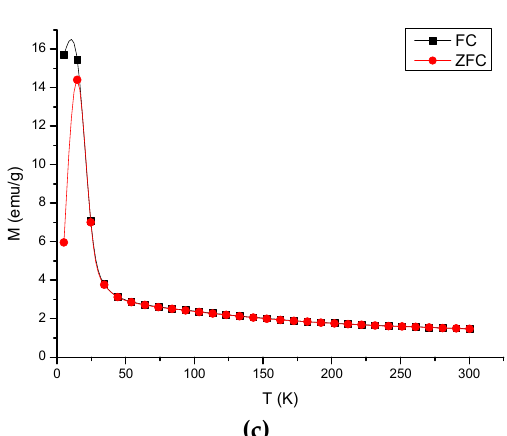
Figure 5. Field-cooling (FC) and zero-field-cooling (ZFC) magnetic moment curves measured for samples: ( a ) PVA gels containing 2.3% Ni; ( b ) 4.5% Ni; and ( c ) pure Ni nanoparticles. The lower curve of each sample represents the ZFC measurement and the upper one represents the FC measurement.